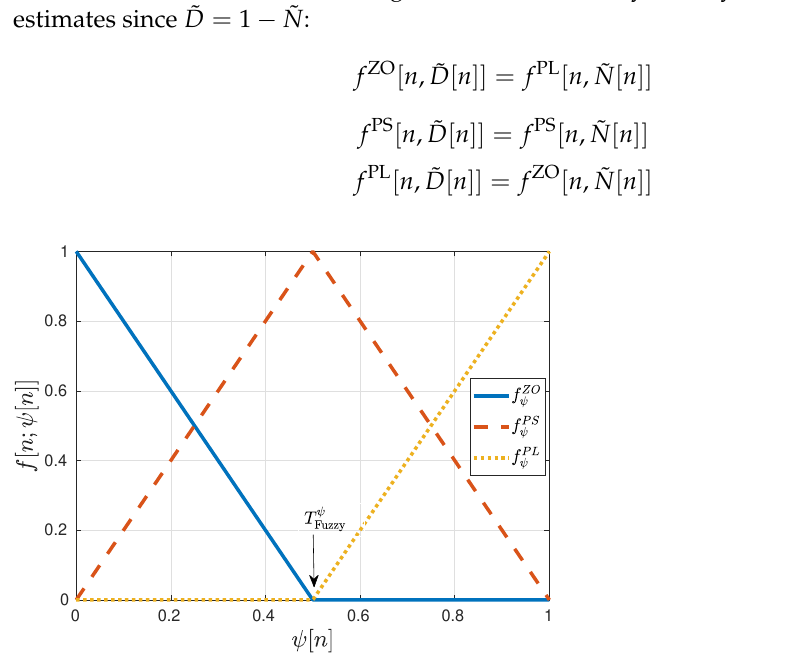
Figure 8. Fuzzy functions for normalized estimates ˜ D and ˜ N . ©IEEE. Reprinted, with permission, from [7].